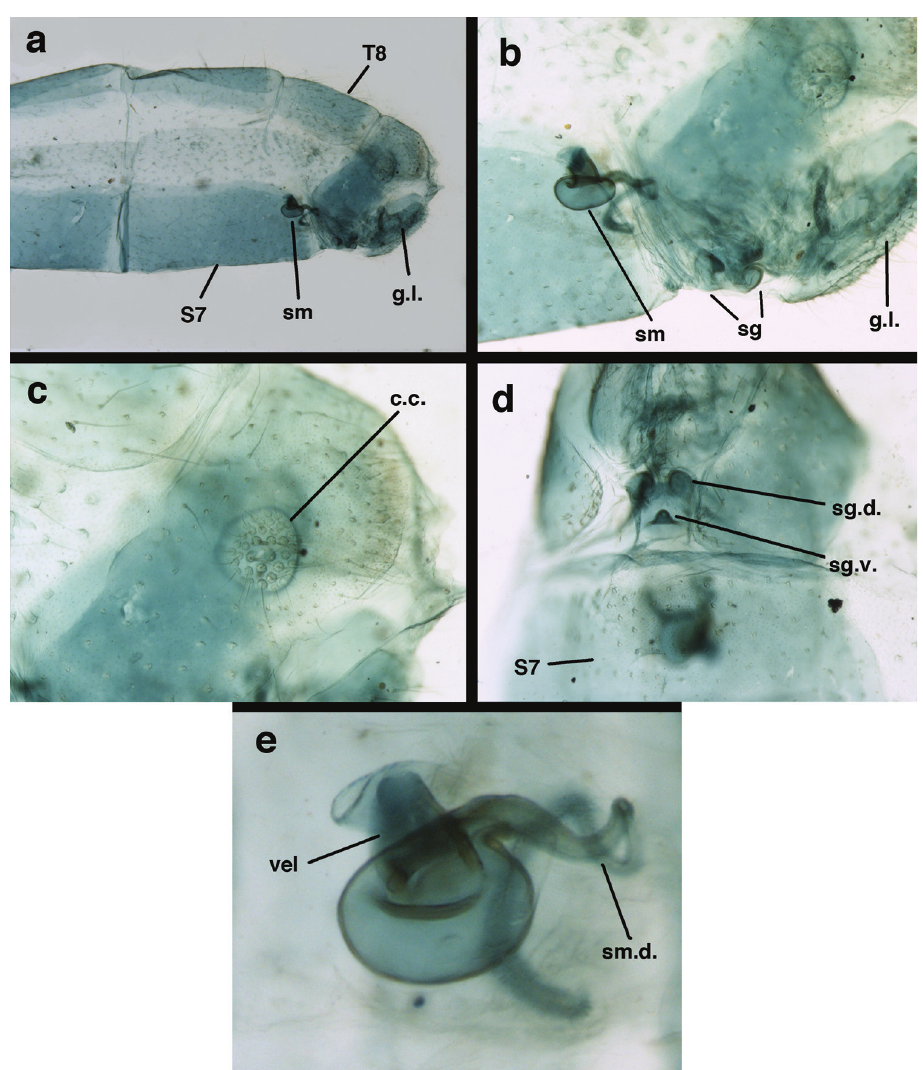
Figure 51. Chrysopa aroguesina Navás: Female abdomen, ( a ) segments A6-terminus, lateral ( b ) termina- lia, lateral ( c ) callus cerci ( d ) terminalia, ventral ( e ) spermatheca. c.c. callus cerci g.l. gonapophysis lat- eralis S7 seventh sternite sg subgenitale sg.d. dorsal lobe of subgenitale sg.v. ventral lobe of subgenitale sm spermatheca sm.d. spermathecal duct T8 eighth tergite vel spermathecal velum (Ecuador, Azogues, lectotype, MNHN).